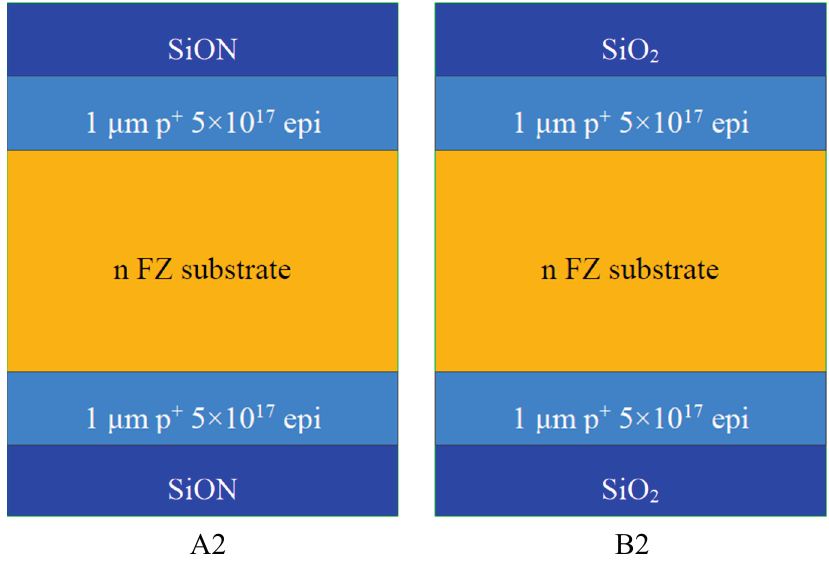
Figure 3. Test structures for p + epitaxial layers and their passivation.